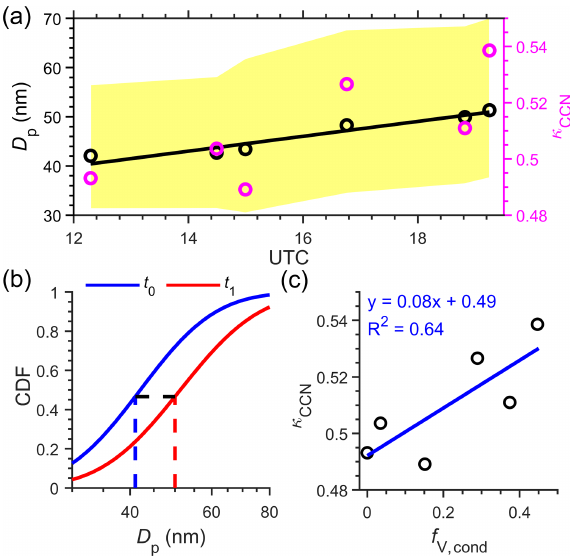
Figure 2. Derivation of κ c , CCN from size-resolved CCN measure- ment during an example condensational growth event. (a) Mode di- ameter and hygroscopicity κ CCN of the growing Aitken mode. The black circles are the fitted mode diameter, D p , n , and the shaded area indicates the 1 σ range of the fitted mode. The black line shows the increasing trend of D p , n , which is used to identify growth events. (b) Derivation of the original particle diameter ( D p0 ) at the beginning of the growth event from particle diameter mea- sured after growth ( D p1 ) using cumulative particle size distribu- tions. (c) Derivation of κ c , CCN through linear fitting of κ CCN vs. f V , cond .